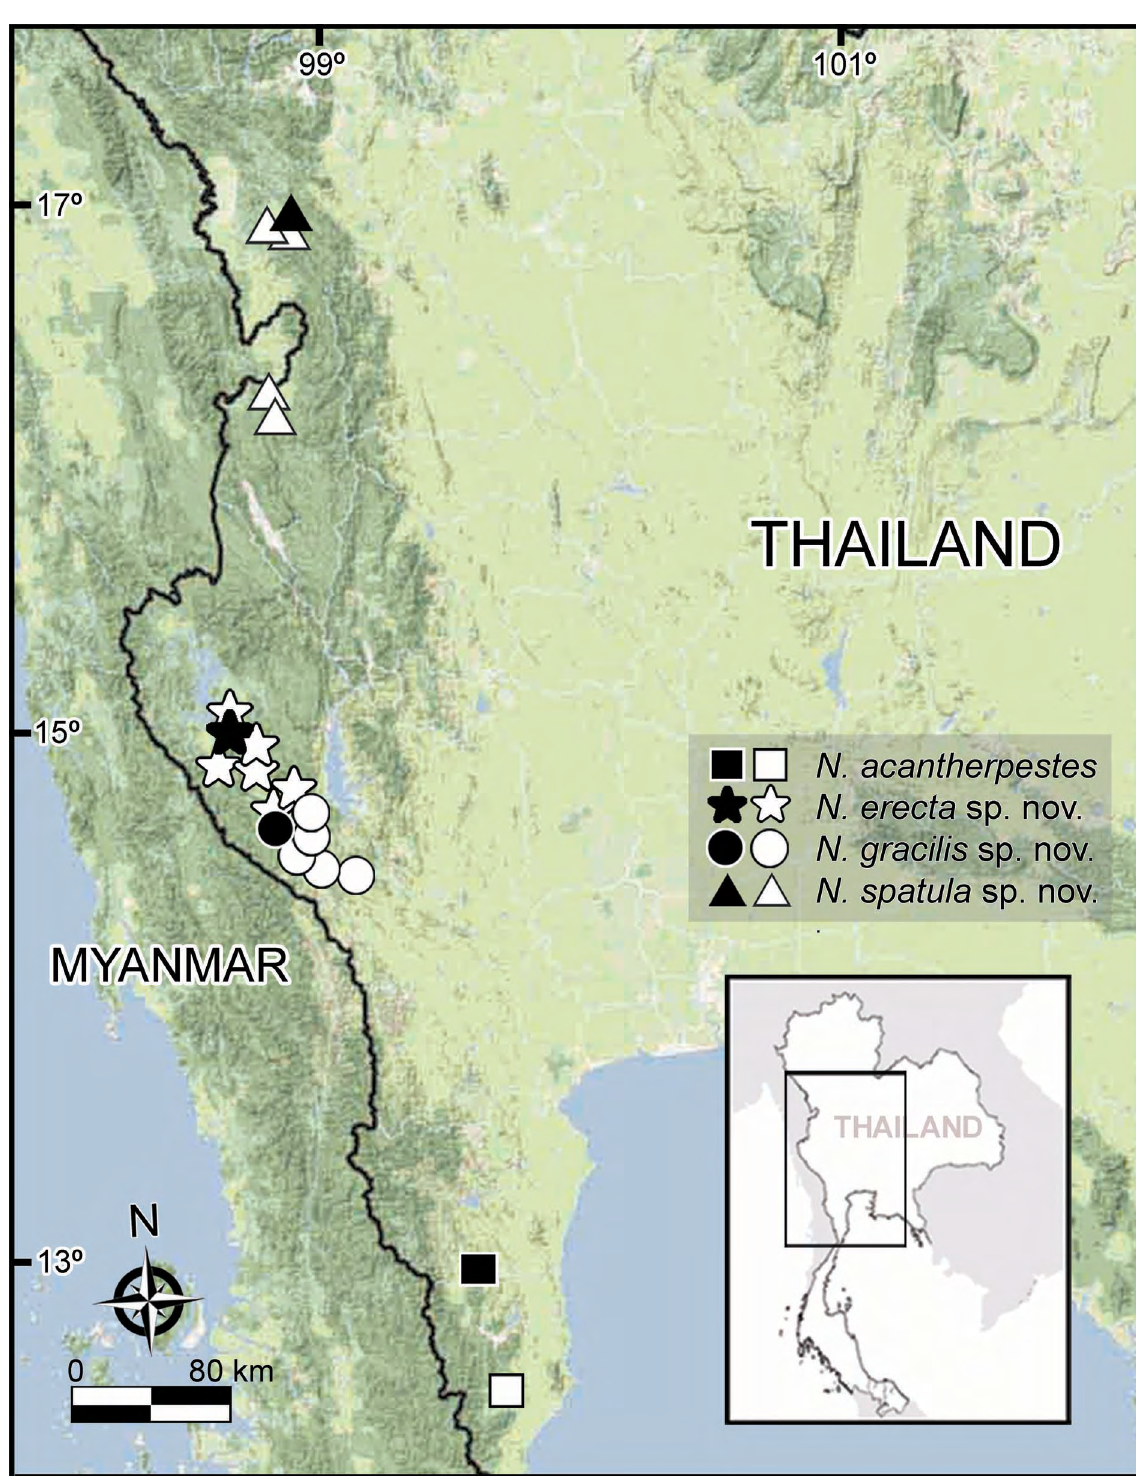
Fig. 27. Known distribution of all species of Nagaxytes Srisonchai, Enghoff & Panha gen. nov. (black symbol = type locality, white symbol = other